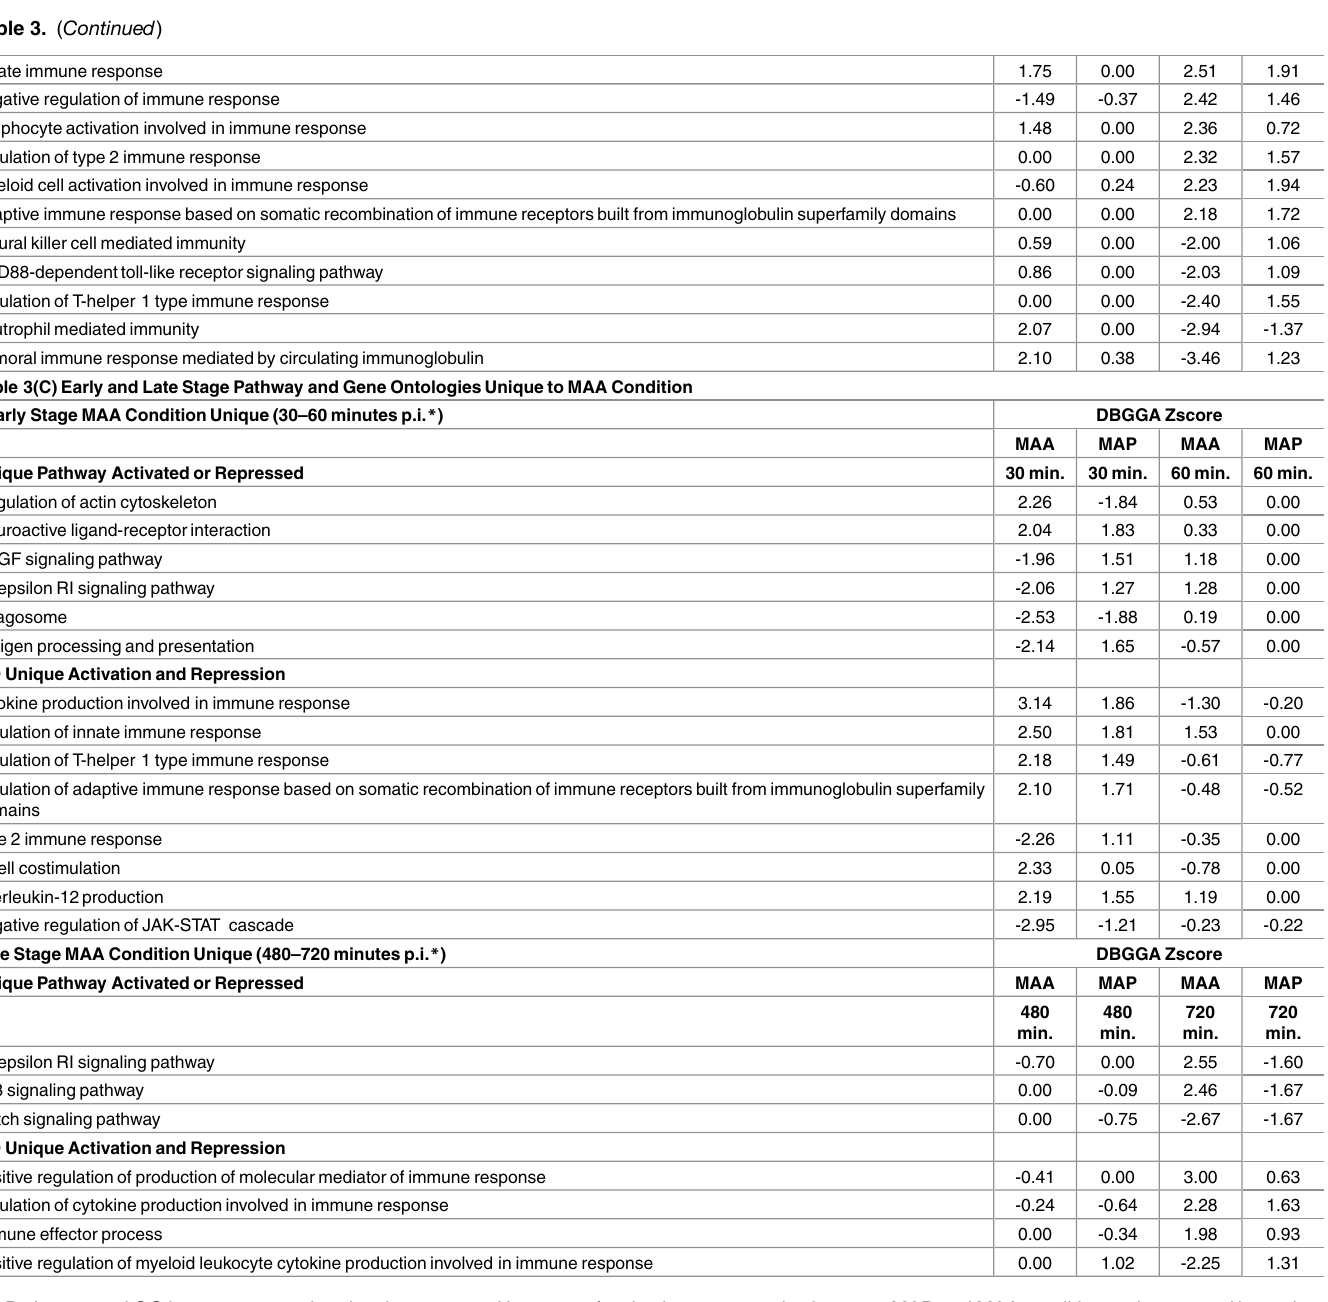
Table 3(C)Early and LateStagePathway and GeneOntologiesUniquetoMAA Condition Eearly StageMAA ConditionUnique(30–60minutesp.i. * )